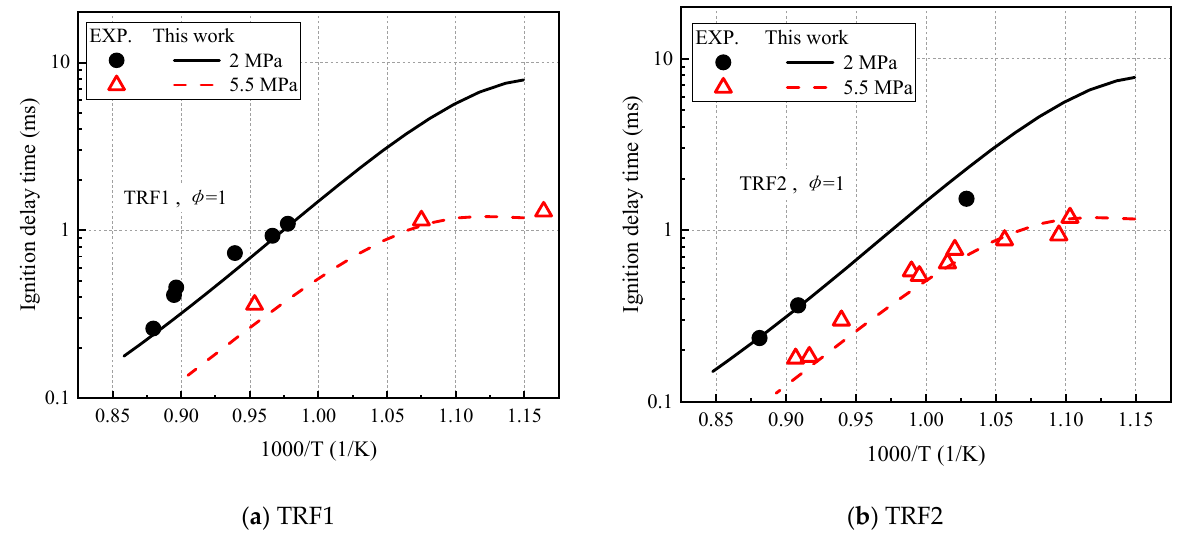
Figure 8. Verification of the ignition delay time of TRF1 and TRF2. ( a ) TRF1 and ( b ) TRF2.